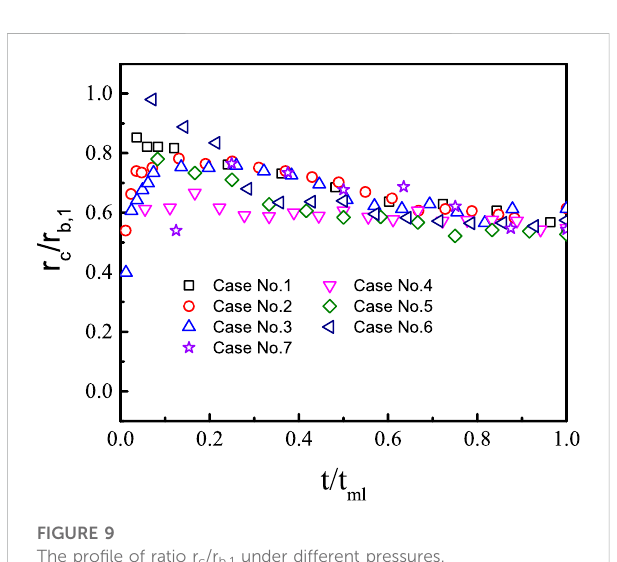
FIGURE 9 The pro fi le of ratio r c /r b,1 under different pressures.